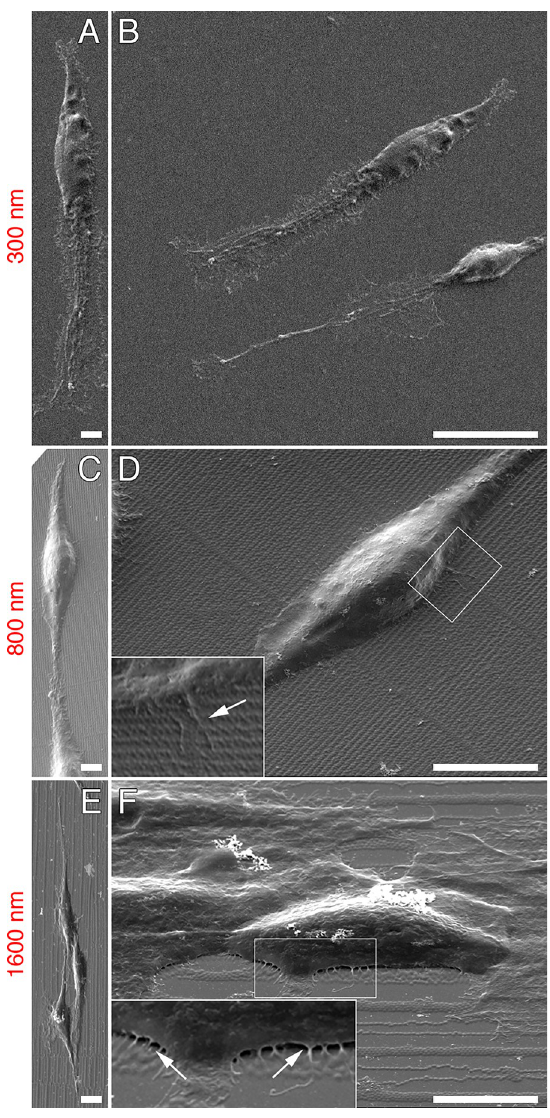
Fig 8. Scanning electron microscopy analysis of microgel-cell interaction. B16F1 cells were seeded on 300 nm (A, B), 800 nm (C, D) and 1600 nm (E, F) microgel arrays, incubated at 37˚C, 5% CO 2 for 24 hours and then fixed and processed for scanning electron microscopy. Regardless of the spacing of the array, cells fully responded to microgel topography, acquiring an elongated morphology with their major axis parallel to that of the arrays (A, C, E). Cells also generated thin projections that were in contact with microgels (arrows in insets of panels D and F). Scale bars: 4 μ m (C), 10 μ m (D, E,